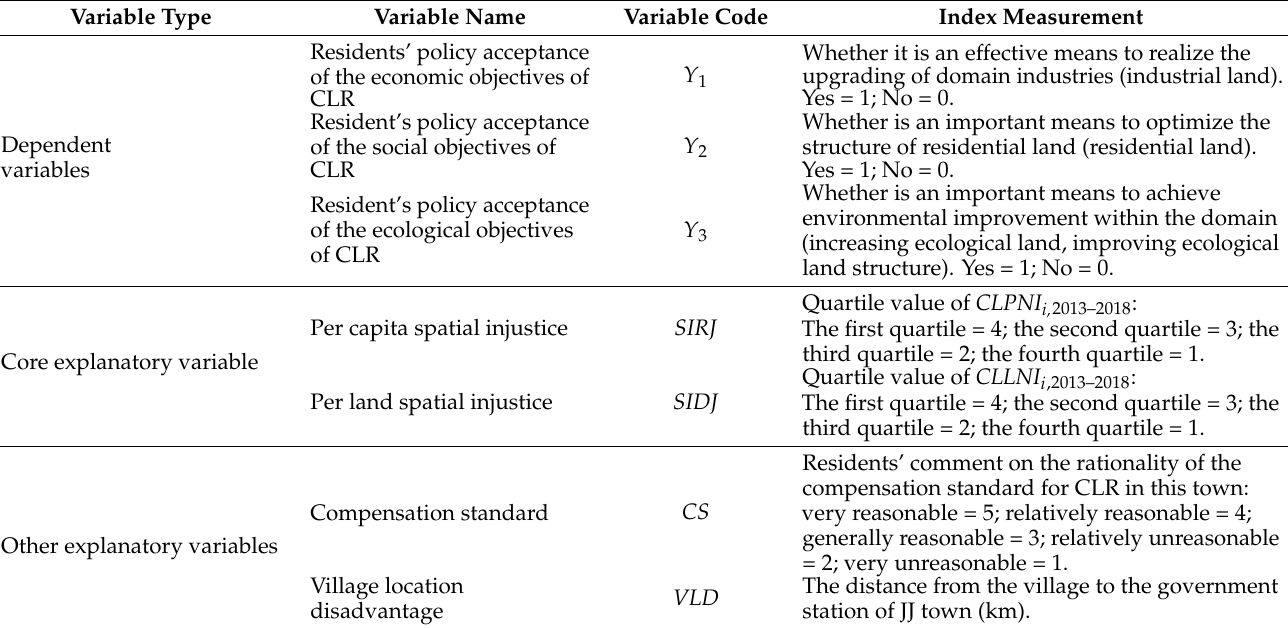
Table 1. Model variable explanation and index